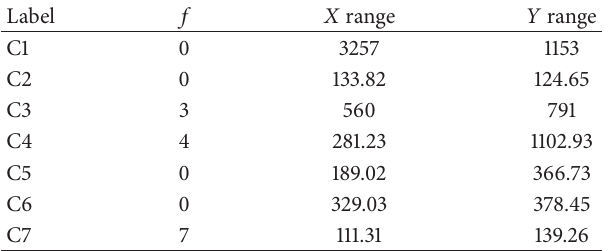
Table 3: Standard data in data set C.